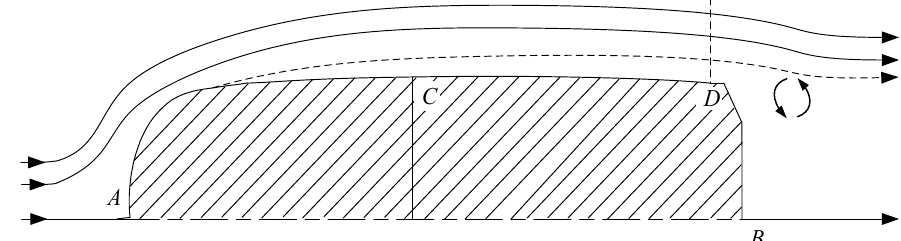
Figure 3. Diagram of HSAV streamline.